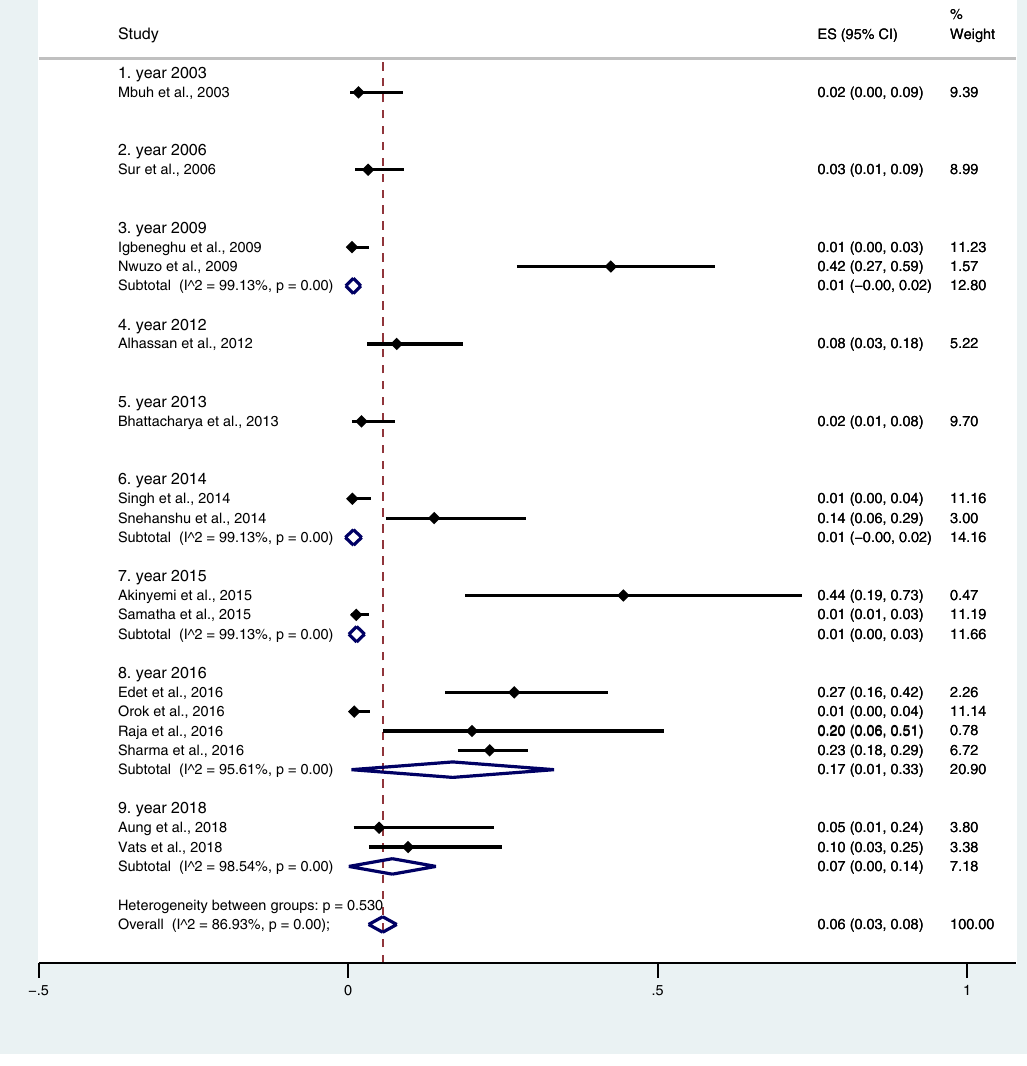
Figure 19. Prevalence of Salmonella spp. infection among patients with malaria using blood cultures for the identification of Salmonella spp. infection stratified by time (publication years). ES proportion estimate (multiply 100 units for interpreted as prevalence estimate), CI confidence interval, NS not